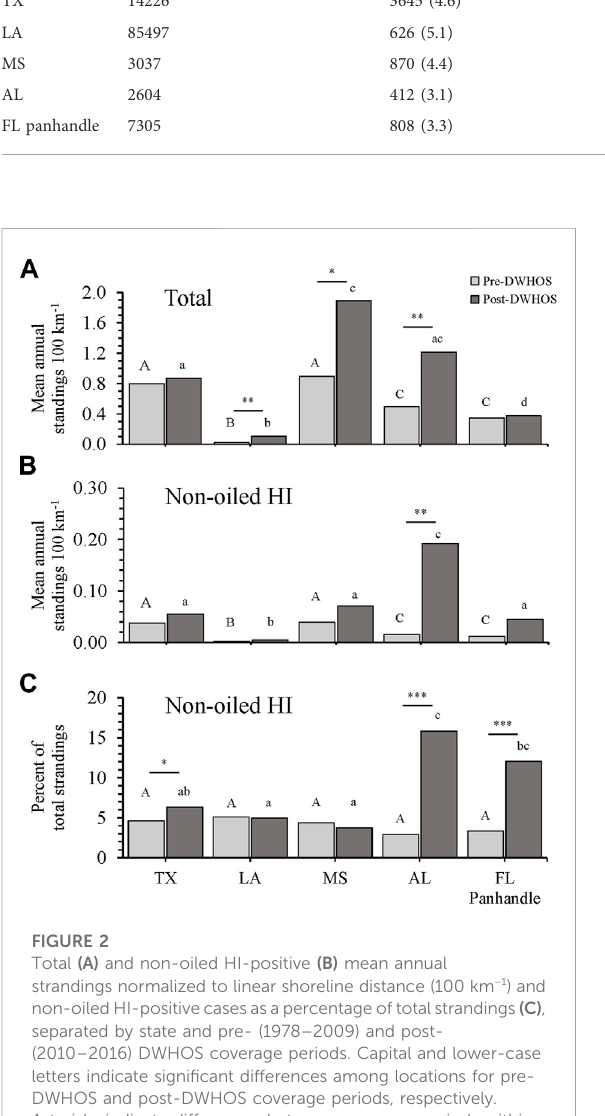
performed in R v3.4.1, SingleCandle .